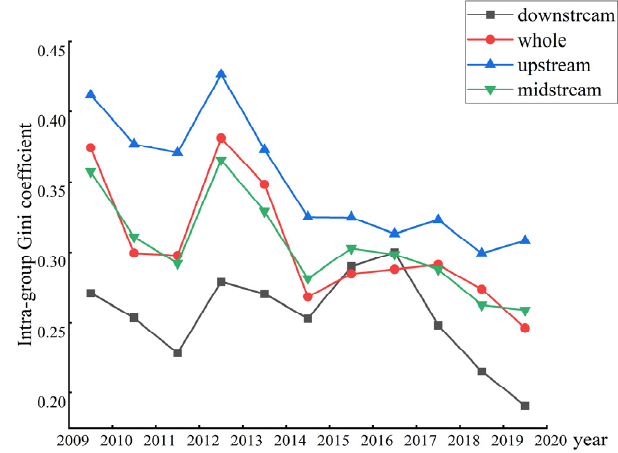
Figure 4. Inter-regional differences of the EWP in the YREB.